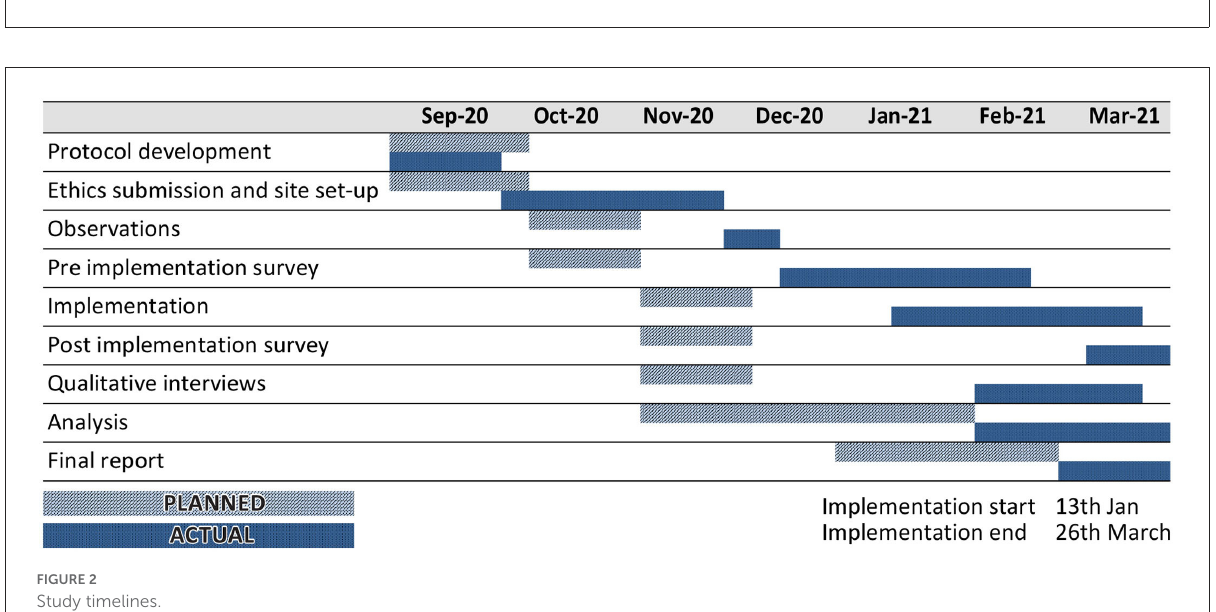
FIGURE1 Study flowchart.